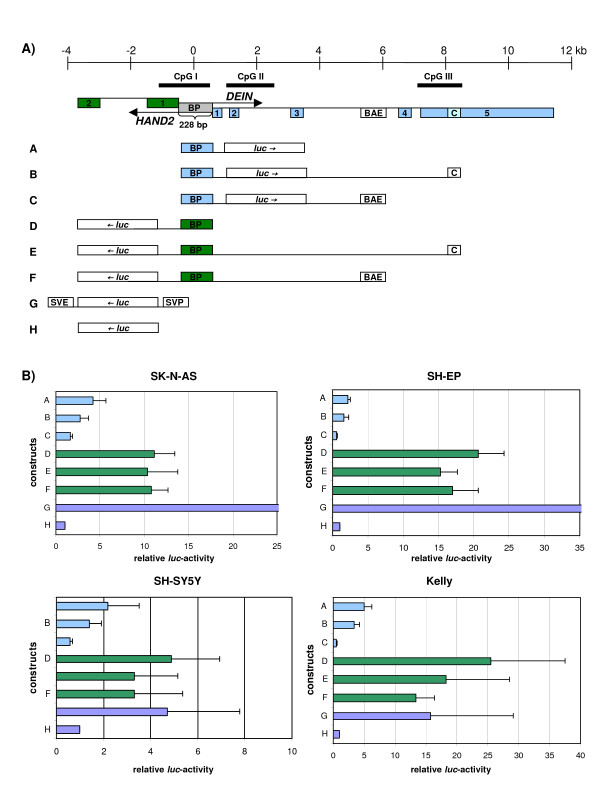
Genomic organization of the human HAND2-DEIN locus on 4q33–34 and luciferase reporter-gene constructs A-H (A); Relative luciferase activity of constructs A-H in NB cell lines SK-N-AS, SH-EP, SH-SY5Y and Kelly (B). Boxes and lines indicate exons and introns, respectively. Arrows indicate direction of transcription. Blue bars, DEIN orientation; green bars, HAND2 orientation; BP, Bidirectional Promoter; luc, luciferase; BAE, HAND2 Branchial Arch Enhancer; C, putative cis-regulatory element; SVE/SVP, SV40 enhancer- and promoter-elements, respectively. Values of transfection experiments are shown as the mean ± standard deviation of 3 independent experiments. Values are normalized to the activity of the pGL3-Basic vector set as 1.